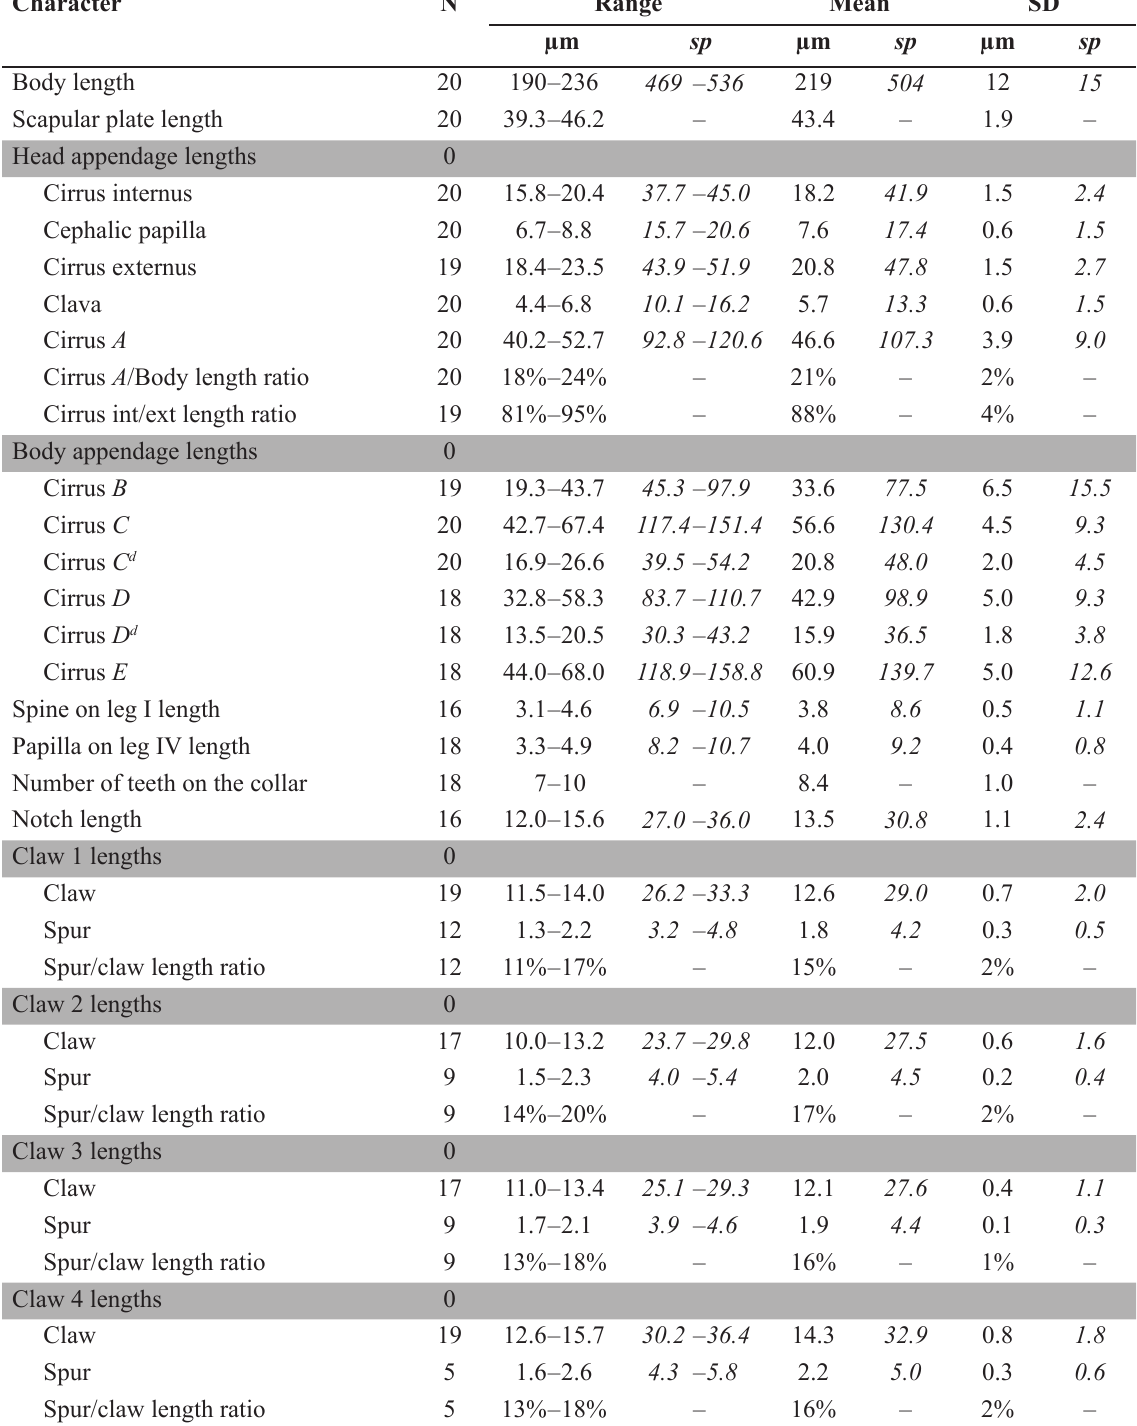
Table 2. Measurements (in µm) and sp values of selected morphological structures of adult males from the neotype population of Echiniscus q. quadrispinosus Richters, 1902 mounted in Hoyer’s medium. Abbreviations: N = number of specimens/structures measured; RANGE = refers to the smallest and the largest structure among all measured specimens; SD = standard